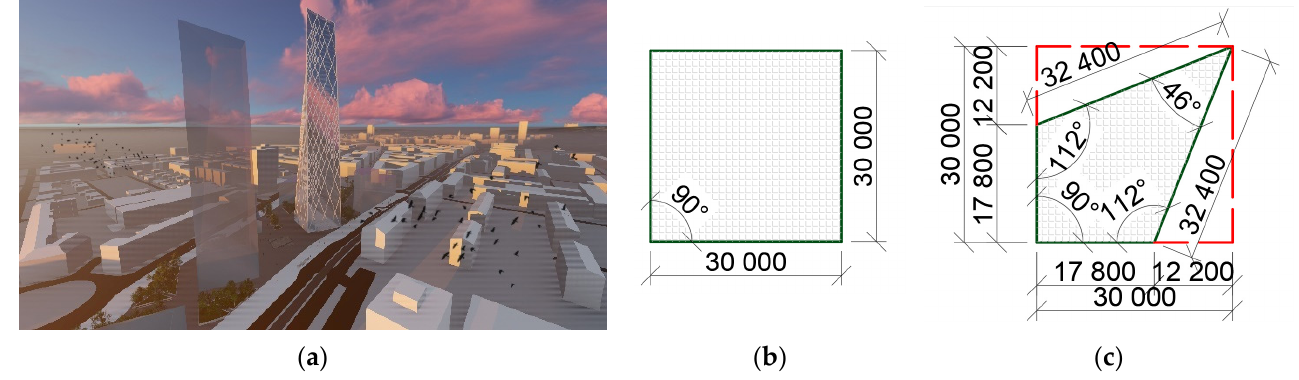
Figure 3. ( a ) Architectural design of the high-rise building; ( b ) the ground plan in bottom part of the building; ( c ) the top of the building.